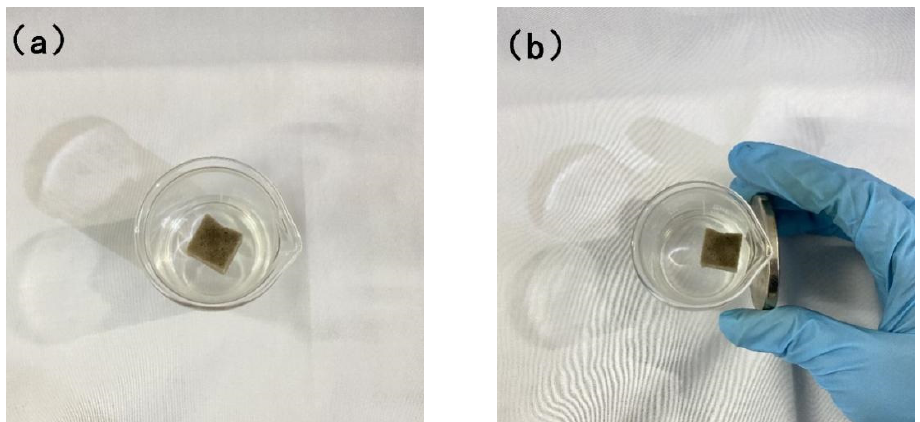
Figure 11. ( a , b ) the appearance of PDMS@Fe 3 O 4 /MS after deoiling 5 times, 10 times, 15 times, and 20 times and ( c ) The paper towel absorbs the residual oil in the sponge.